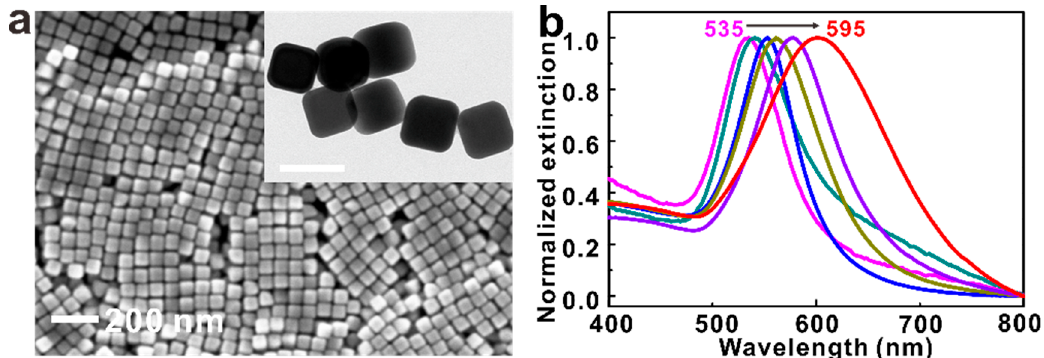
Figure 1. Synthesized Au nanocubes and their plasmonic properties. ( a ) The SEM and TEM images of the as-prepared AuNCs. The scale bar is 100 nm in the inset TEM image. ( b ) The extinction spectra of synthesized AuNCs, demonstrating tunable plasmon resonance mode from 535–595 nm.